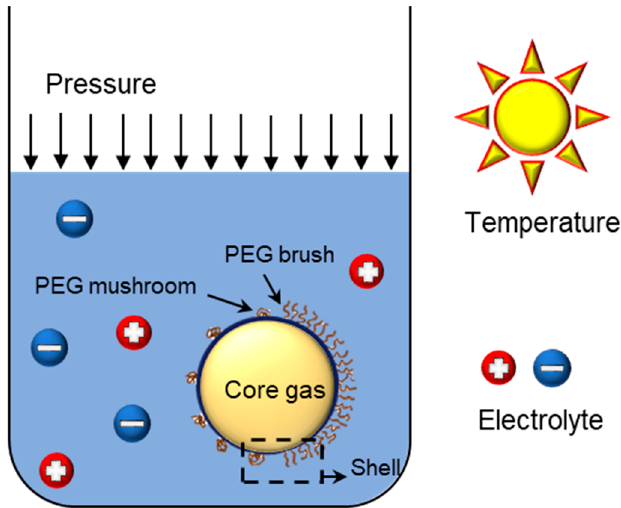
Figure 1. Factors affecting bubble stability. Figure 1. Factors a ff ecting bubble